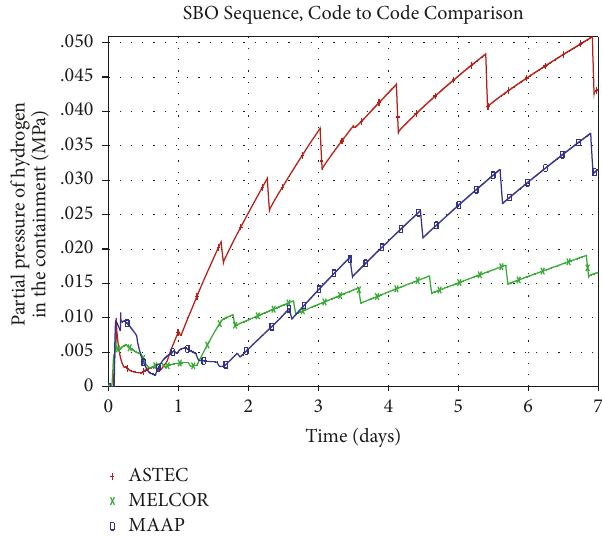
Figure 10: Containment pressure behaviour and indication of failure criterion in the case without safety systems. Figure 11: Partial pressure of hydrogen in the containment.